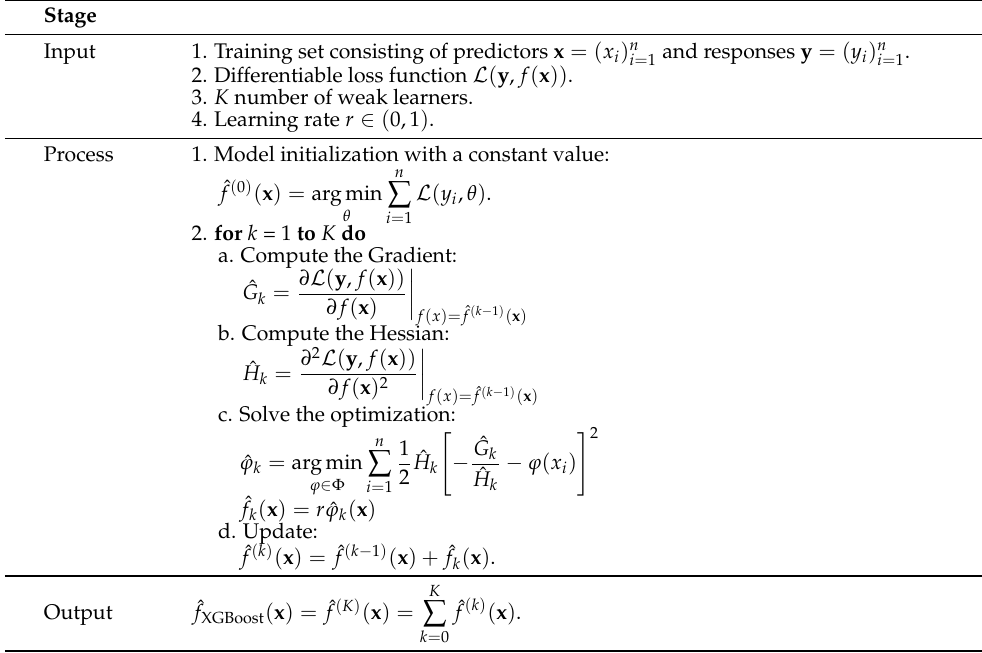
Table 1. XGBoost algorithm (Chen and Guestrin 2016; Mushava 2022).